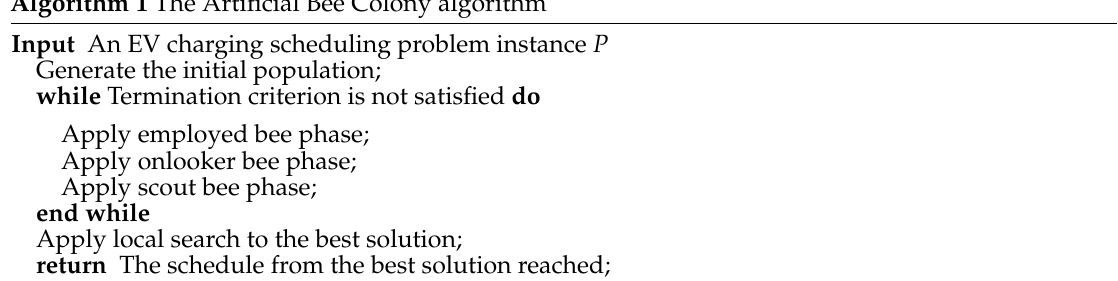
Algorithm 1 The Artificial Bee Colony